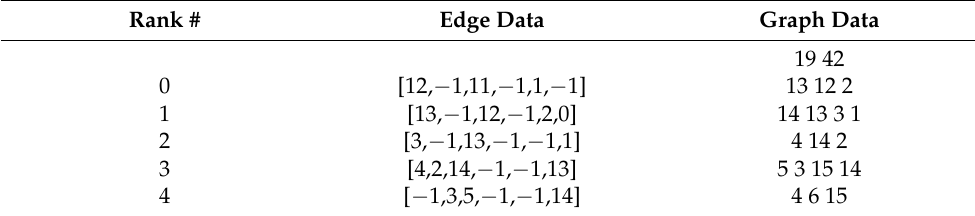
Table 1. The edge file and graph file of the 3-ring 19-assembly example. Rank